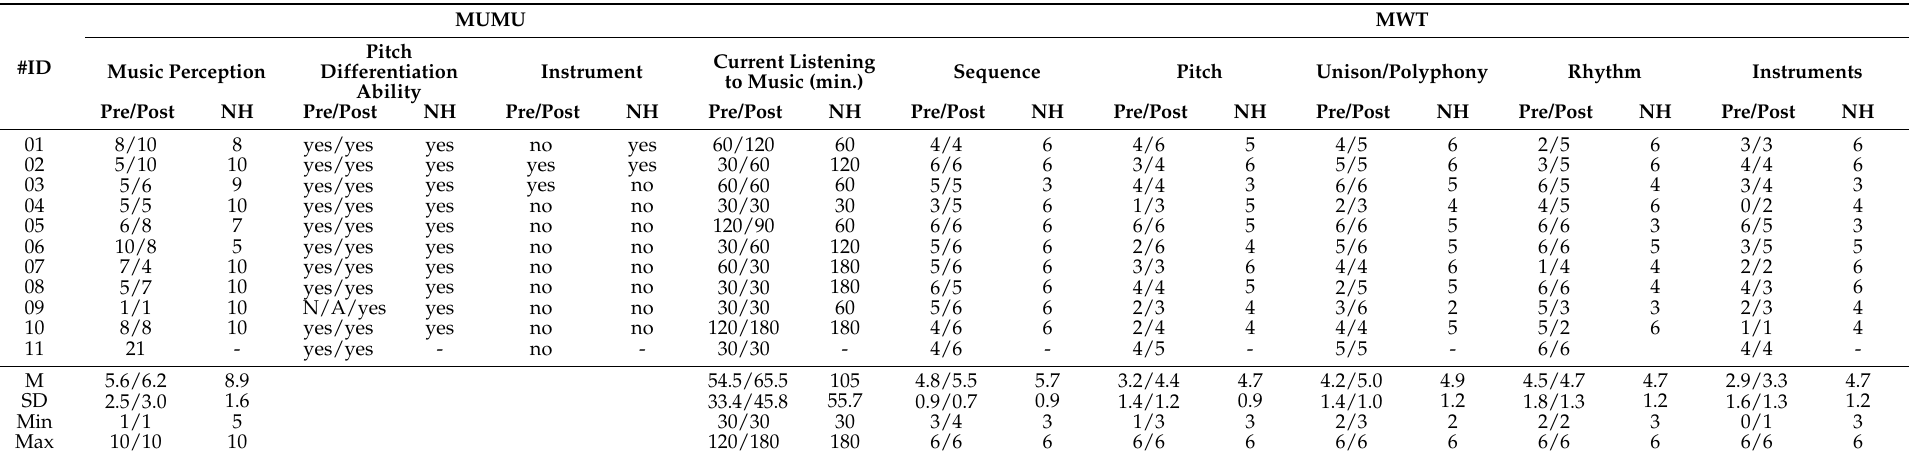
Table 4. Outcomes of the questionnaires MUMU and